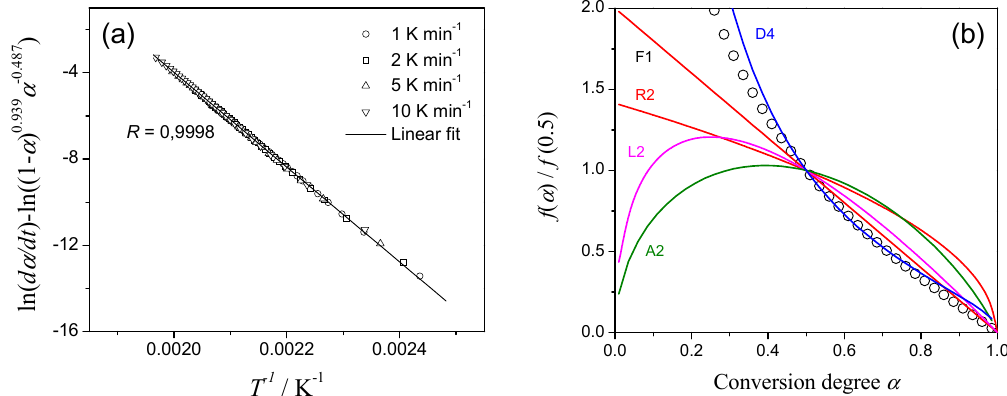
Figure 4. CKA analysis of the first reaction step of Case 1 deconvoluted from DSC curve by assuming two successive exothermic processes. ( a ) CKA plot, ( b ) Comparison of theoretical master plots of different kinetic models with calculated data (circles).